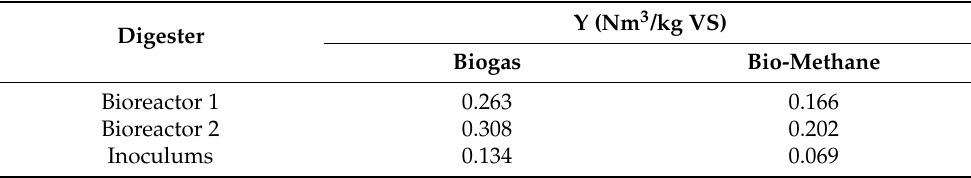
Table 4. Specific rate values of the biogas/bio-methane in the bioreactors and in the inoculums.